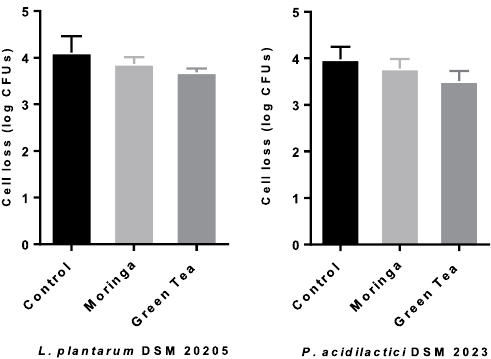
Fig. 4. Reduction of control encapsulated probioticcells (CC) and novel encapsulated probioticcells (NC) with herbal extracts in drinkable yoghurt at the end of storage at